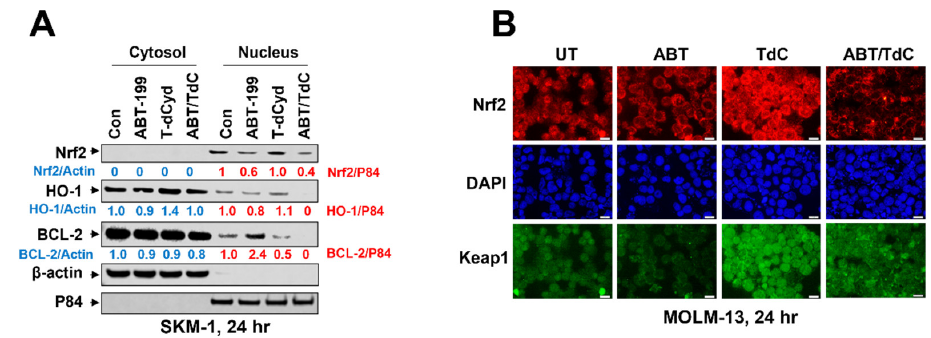
Figure 5. ( A ) SKM-1 cells were exposed (24 h) to ABT-199 ± T-dCyd (1 µM each), after which cytosolic and nuclear fractions were monitored for NRF2, HO-1, and BCL-2 expressions by WB analysis. Images were quantified and analyzed by using ImageJ software. Data were normalized to the ratio of the indicated protein and β-actin/P84 versus control. ( B ) MOLM-13 cells were exposed (24 h) to T-dCyd (500 nM) ± 2 nM ABT-199, after which the nuclear disposition of NRF2 was monitored by immunofluorescence microscopy.